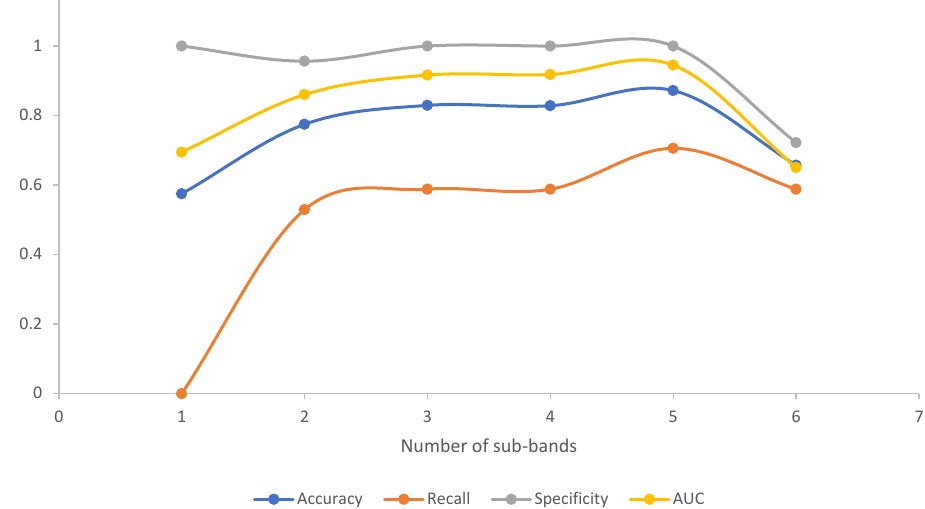
Figure 5. Line charts of classification results of EEG microstate parameters in different sub-bands, in which the number of sub-bands on the x-axis is the same as in Table 4. Four criteria were used to evaluate the classifier model. Obviously, the classification effect of the classifier model in the γ -band was better than in other